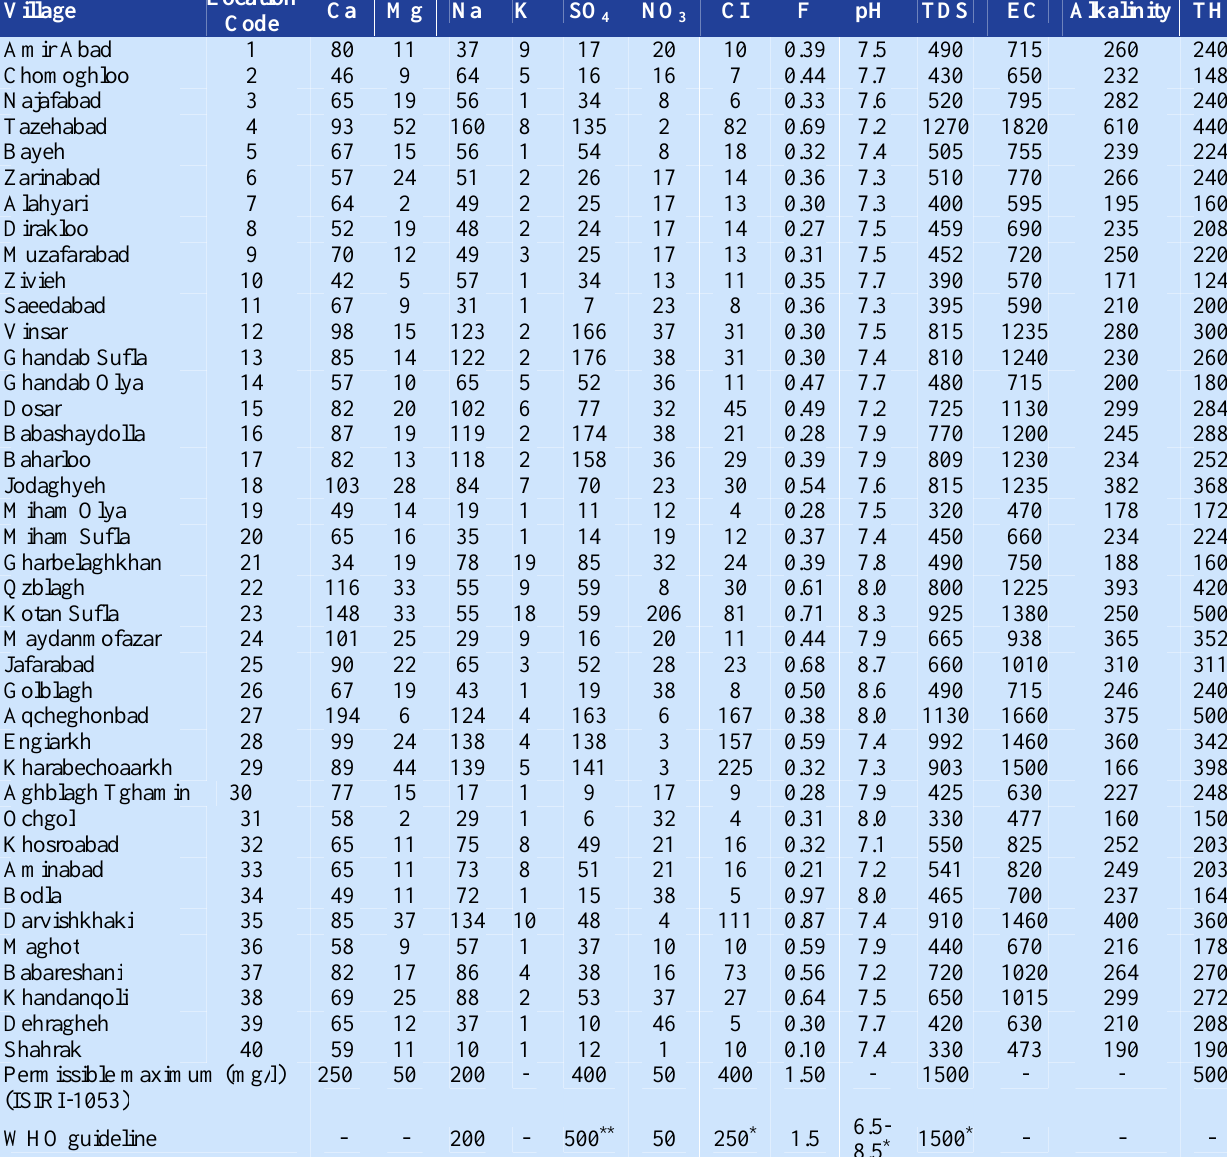
Table 2. Average concentration of physicochemical parameters of groundwater in rural areas